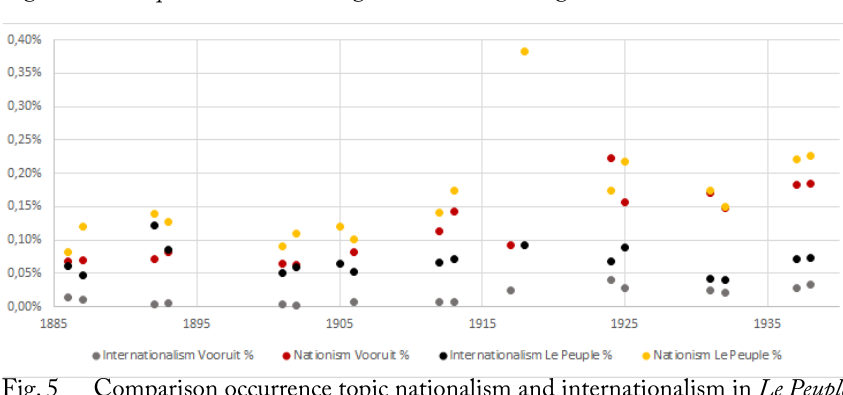
Figure 4: Le Peuple - Focus on Belgium versus other regions (1886-1938) Fig. 4 Le Peuple — Focus on Belgium versus other regions (1886–1938)